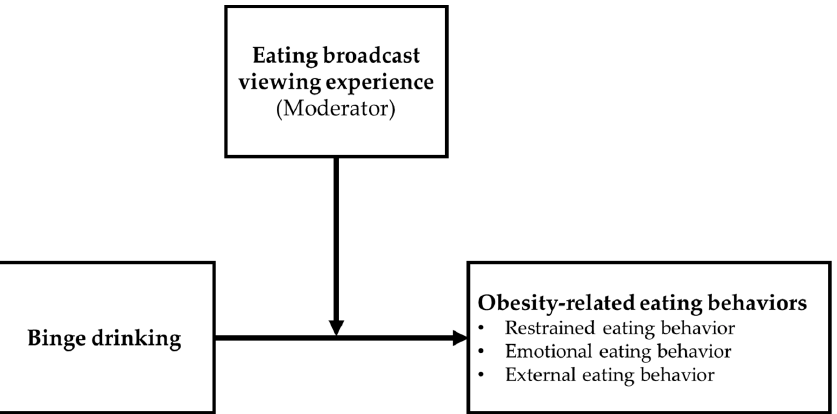
Figure 1. Conceptual model explaining obesity-related eating behaviors by binge drinking and eating broadcast viewing experiences.